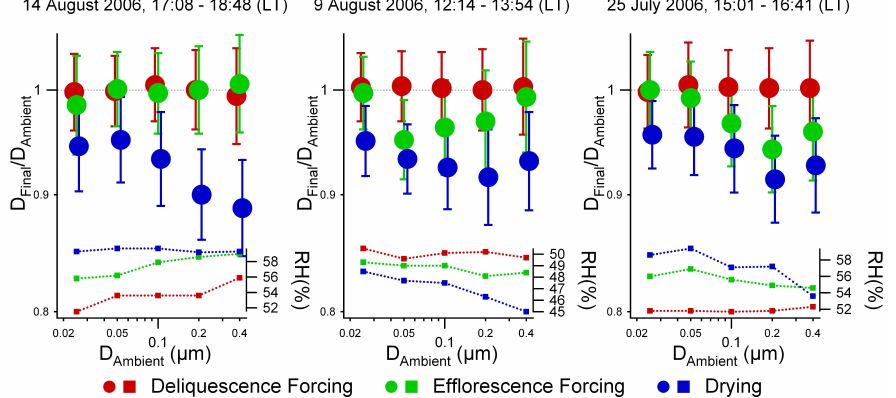
Fig. 6. The results of three AS-TDMA full measurement cycles from the summer campaign. The point and error bar markers follow the convention described in Sect. 2.3: each point characterizes a mode in the size distribution. The size of the point reflects the relative contribution of the mode to the concentration of particles having that ambient diameter; the vertical position depicts the characteristic ratio of post-process to ambient size of particles in the mode; and the error bars describe the breadth of the mode. Below the measurement results is the ambient RH during each measurement. The slight lateral offset between the results from each process is artificial and for clarity